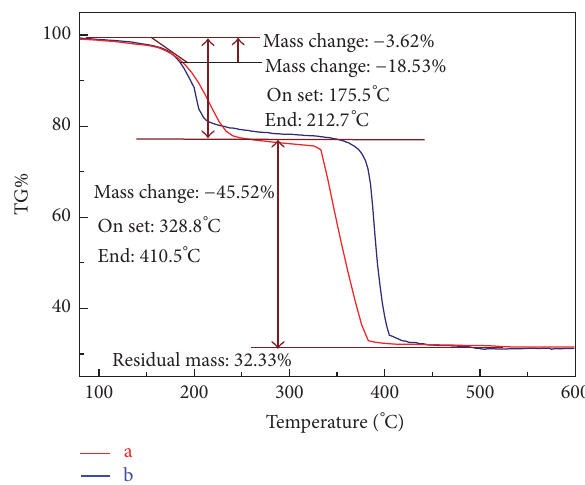
Figure 7: TG results for precursor under N 2 atmosphere: (a) sample (a) mechanical solid-state reaction; (b) sample (b)